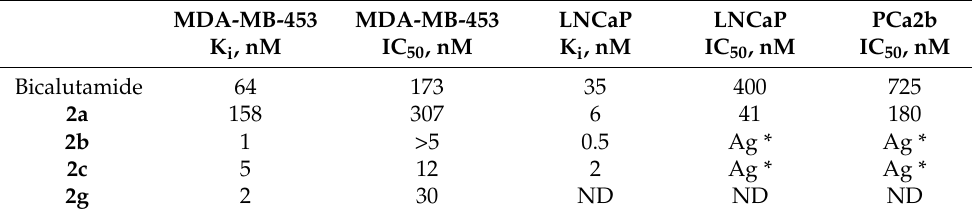
Table 1. Binding (K i ) and IC 50 values for different cancer cell lines produced by androgen receptor (AR) antagonist containing norbornene [29 ‐ 30],[32].